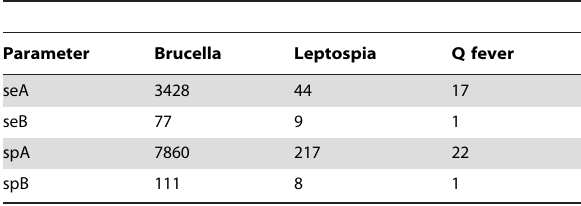
Table 1. Priors used for each diagnostic test for modeling true